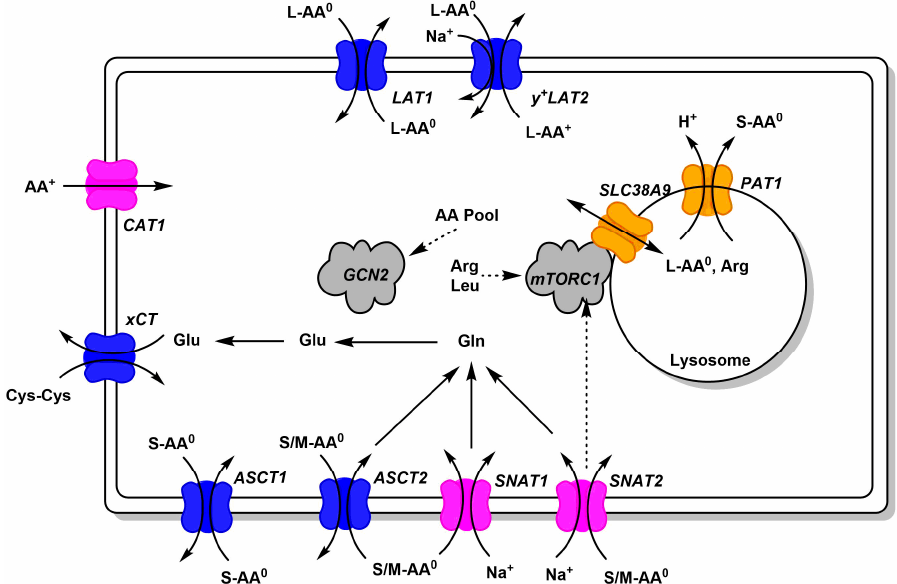
Figure 2. Common amino acid transporters in cancer cells. Amino acid transporters, which are abundant in cancer cells, are shown. Antiporters (harmonizers) are shown in blue, uniporters and symporters in magenta (loaders), and lysosomal transporters in orange. Substrate specificity is indicated using AA 0 (neutral amino acids) and AA + (cationic amino acids, arginine, lysine, ornithine). Size of neutral amino acids is indicated as small (S, glycine, alanine, serine, cysteine, proline), medium (M, threonine, asparagine, glutamine), large (L, leucine, isoleucine, valine, methionine, phenylalanine, histidine, tryptophan, tyrosine). Links to signaling pathways are shown by dashed arrows.